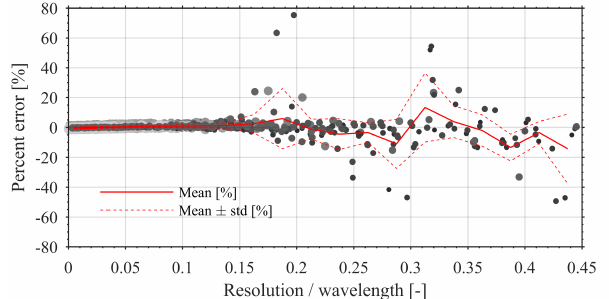
Figure 10. Percent error per image resolution ( ∆ x ) over wavelength ( λ ). The solid red line represents the mean per bin 0.025 [-] (Res/ λ ) and the dotted red lines represent the associated standard deviation ( + / − ). The color and size of the scatter relates to the wave period: the larger the period, the bigger and lighter the